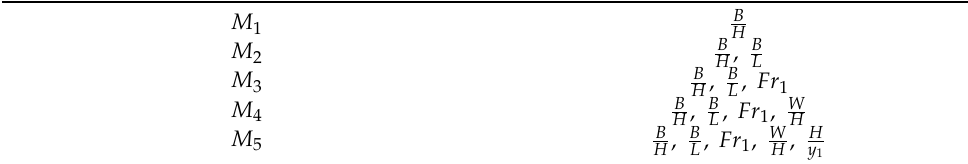
Table 3. Input combinations for estimating C d